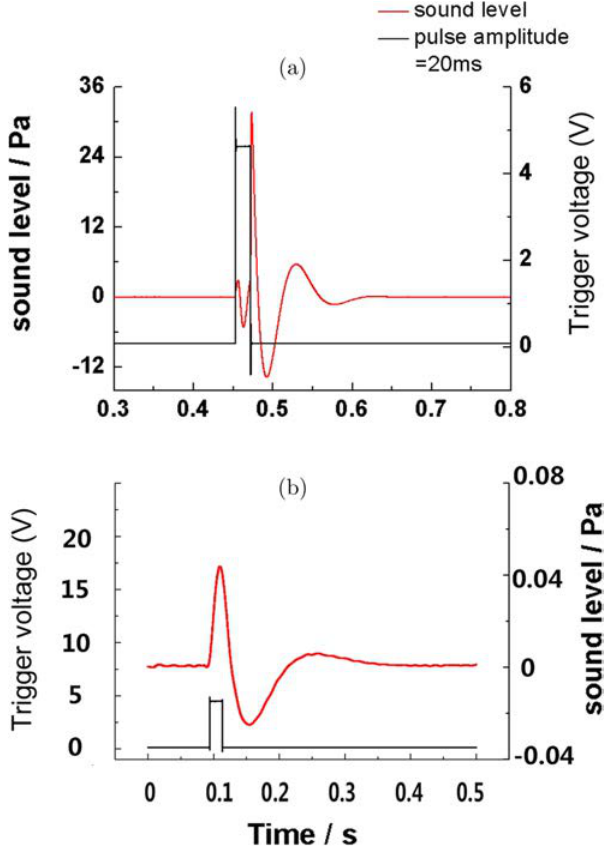
Fig. 7. Optoacoustic e®ect measurement in ambient air. (a) in a water tank and (b) The red color lines represent sound signals and the black ones represent pulsed laser stimulation. Stimu- lation pulse time is 20 ms.